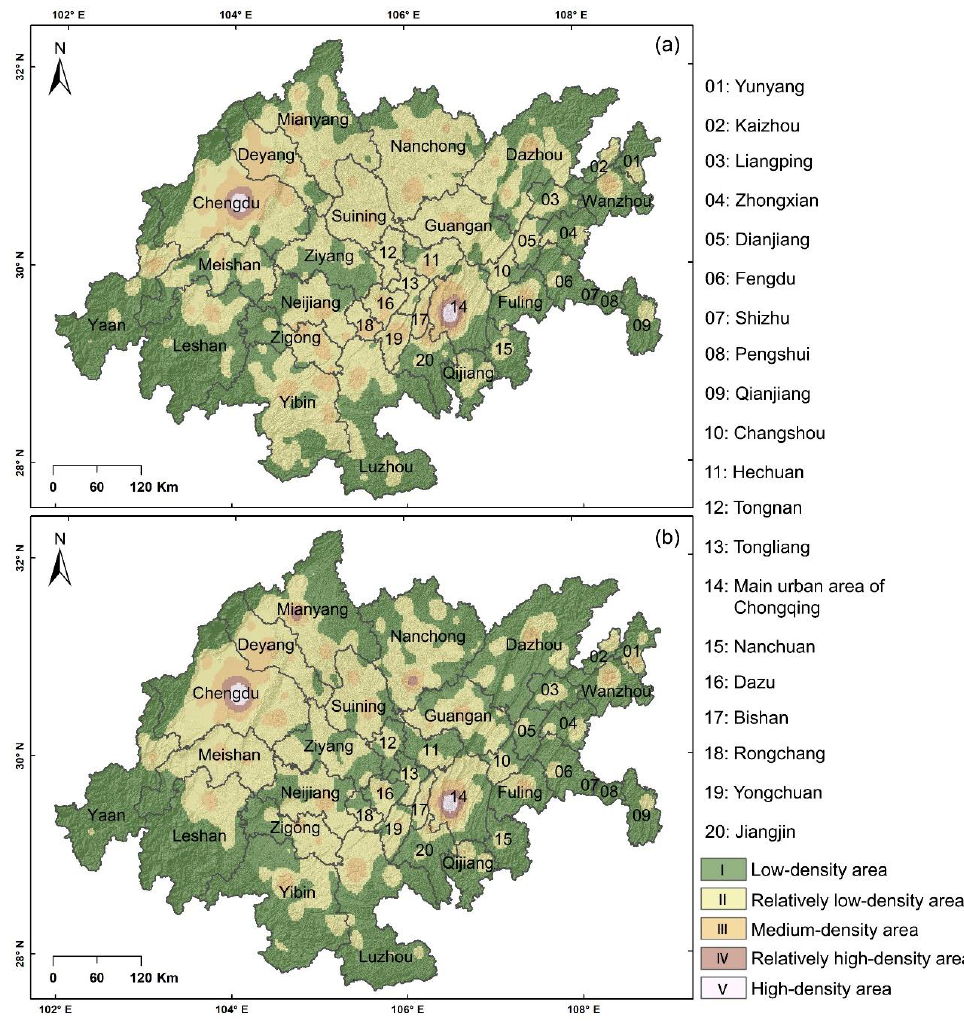
Figure 4. ( a ) Results of KDE of primary schools, and ( b ) results of KDE of middle